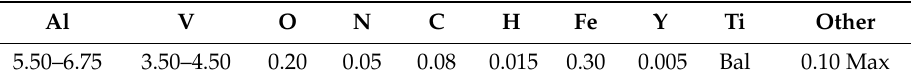
Table 1. Chemical composition of Ti6Al4V powder